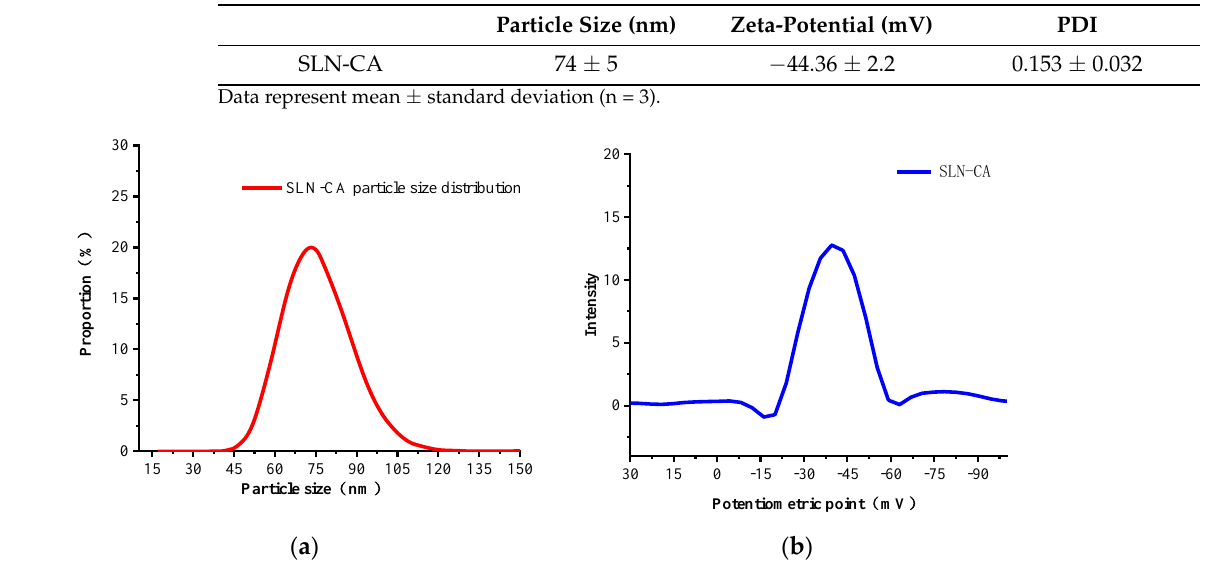
Figure 5. Results of particle size, zeta potential and polydispersity coefficient: ( a ) particle size and distribution; ( b ) zeta potential distribution.